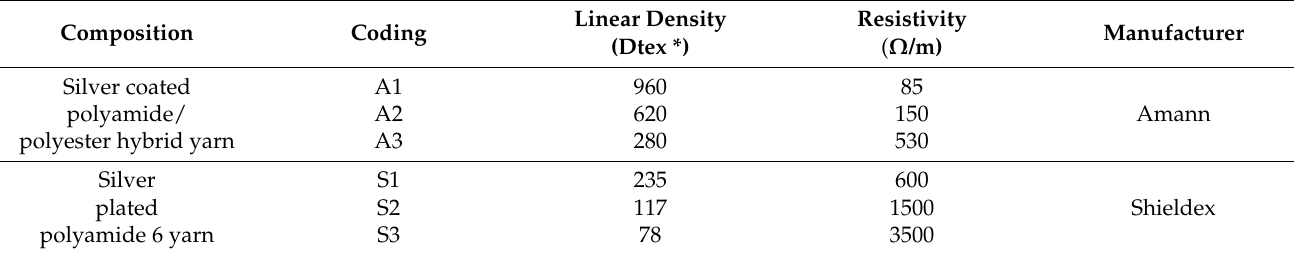
Table 1. Conductive yarn details and related